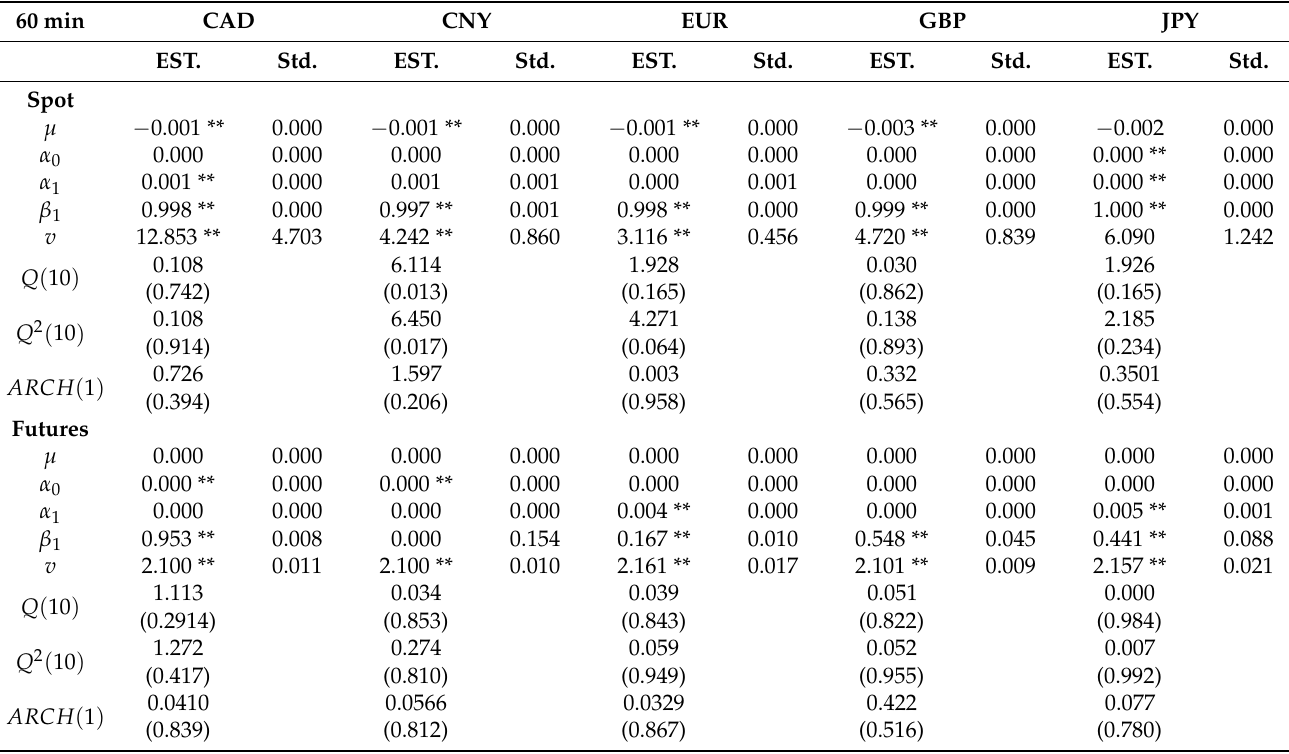
Table 5. Results from the GARCH(1,1) model estimation for 60-min spot and futures returns.